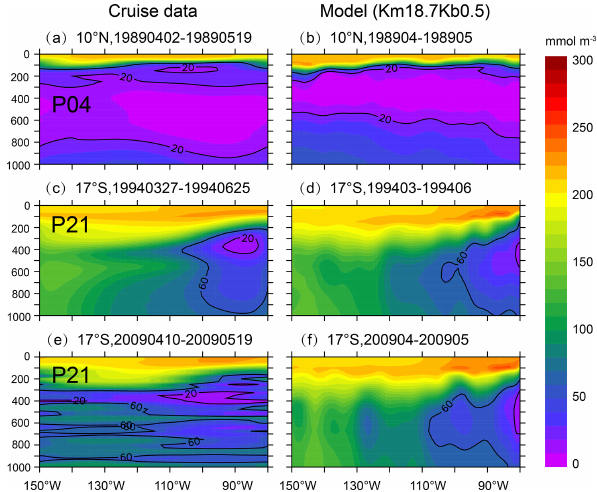
Figure 6. Distribution of DO from cruise data (a, c, e) and model simulation from Km18.7Kb0.5 (b, d, f) . Observed DO data are from CCHDO (https://cchdo.ucsd.edu/ last access: 20 December 2021), along (a) P04 (10 ◦ N) during 2 April–19 May 1989, (c) P21 (17 ◦